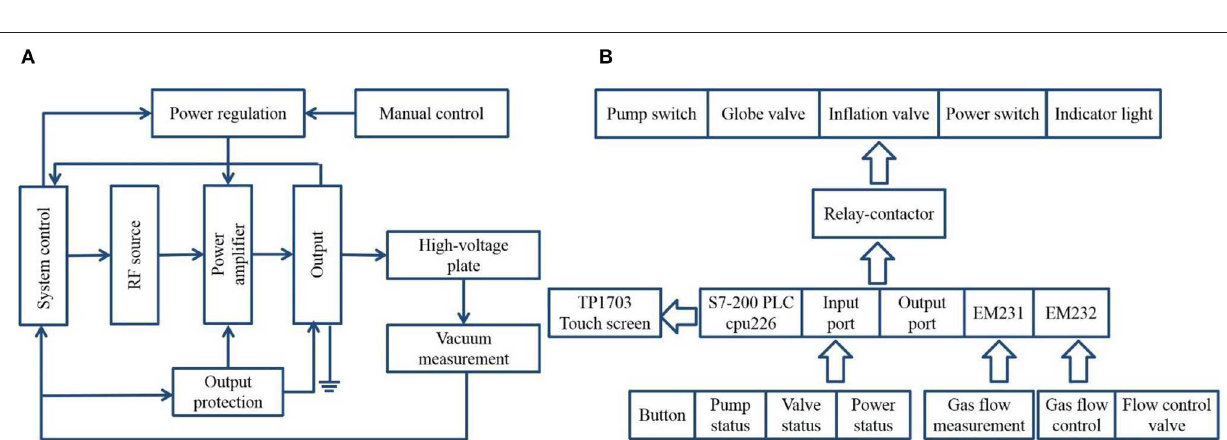
FIGURE 2 | Control principles of capacitive coupled plasma generator. (A) System working flow chart. (B) Programmable logic controller (PLC) control system